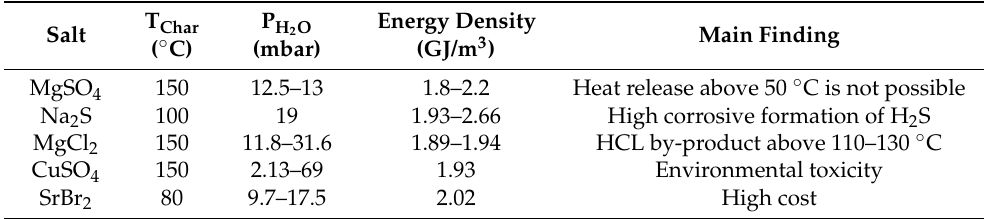
Table 7. Characteristics of salt